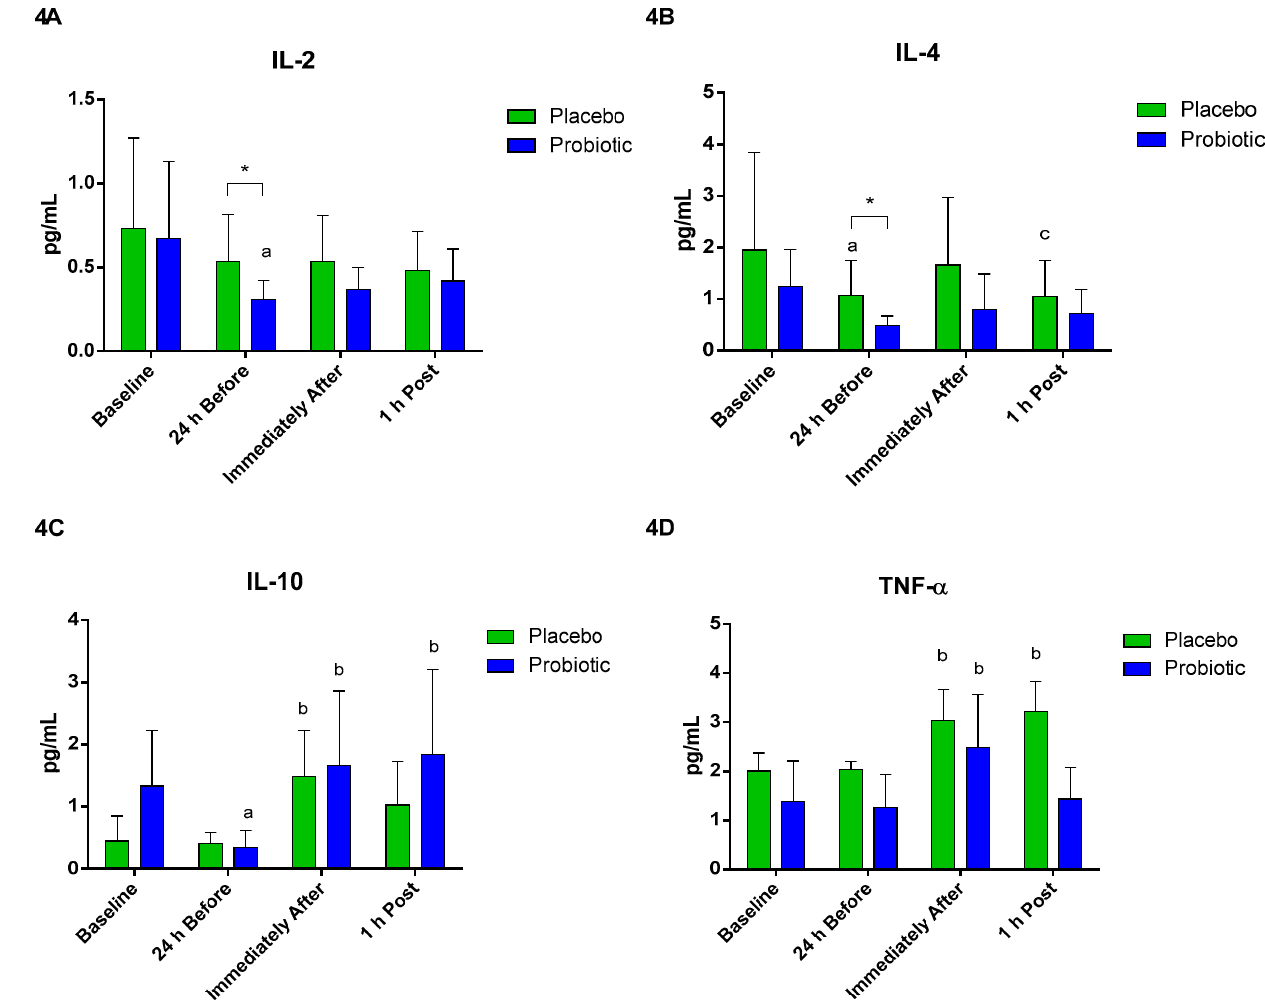
Figure 4. Plasma cytokine concentration. Data presented as mean ± standard deviation. Placebo ( n = 7) and probiotic ( n = 6). The comparison between groups and moments was performed through the general linear model (GLM) with post hoc Tukey. ( A ) IL-2 concentration. ( B ) IL-4 concentration. ( C ) IL-10 concentration. ( D ) TNF- α concentration. a: differs from the ‘Baseline’ of the same group. b: differs from the ‘24 h Before’ of the same group. c: differs from the ‘Immediately After’ of the same group. * difference between groups.